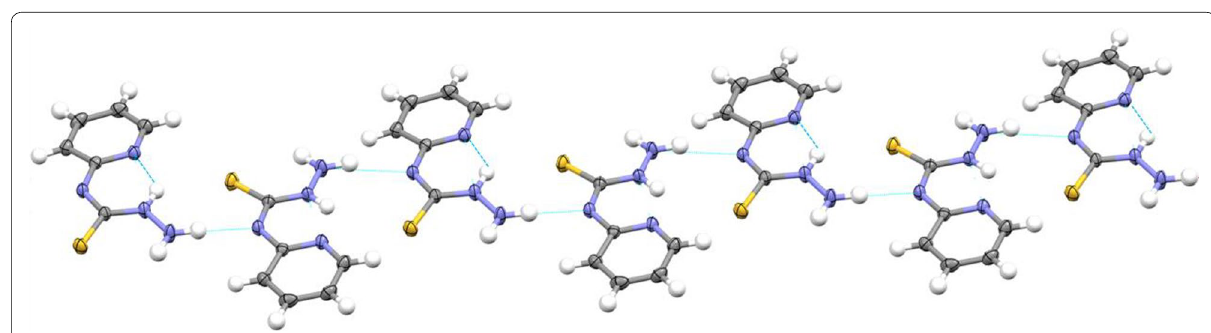
Fig. 8 Hydrogen bridges (green lines) along the ac plane of the unit cell